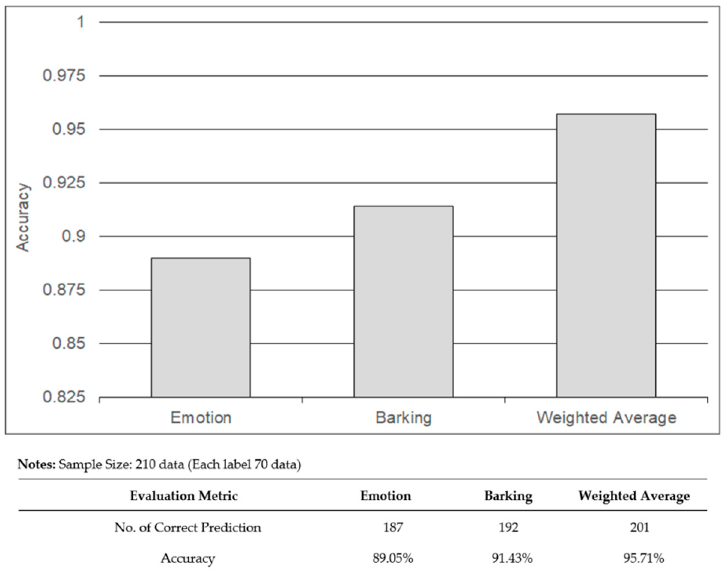
Figure 19. Prediction accuracy obtained from dogs' emotions, dog barking, and weighted average. The weighted average which combines the prediction value of dogs’ emotion and dog barking shows the highest accuracy when compared to emotion and barking.